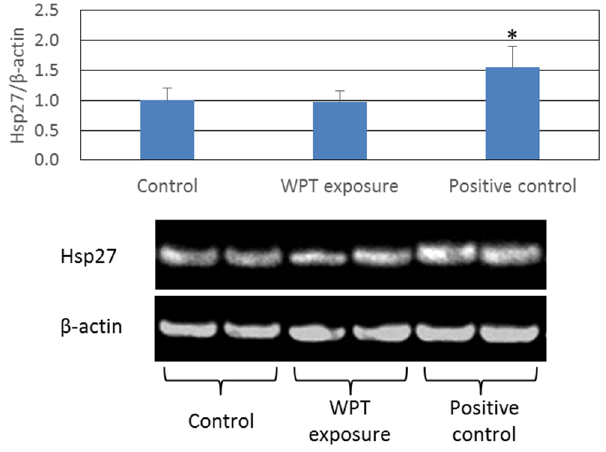
Figure 1. The expression of Hsp 27 in WI38VA13 subcloned 2RA human fibroblast cells exposed to Wireless power transfer (WPT) and control cells for 24 h, or heated at 43 °C as positive control. The expression of Hsp 27 was standardized to that of β -actin. Data are presented as means ± standard deviation (SD) from three separate experiments.